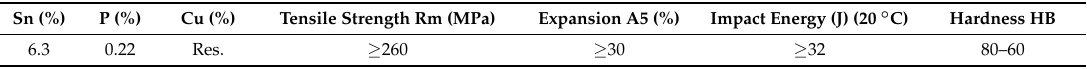
Table 3. Chemical composition of S Cu 5180A—EN ISO 24373 and its mechanical